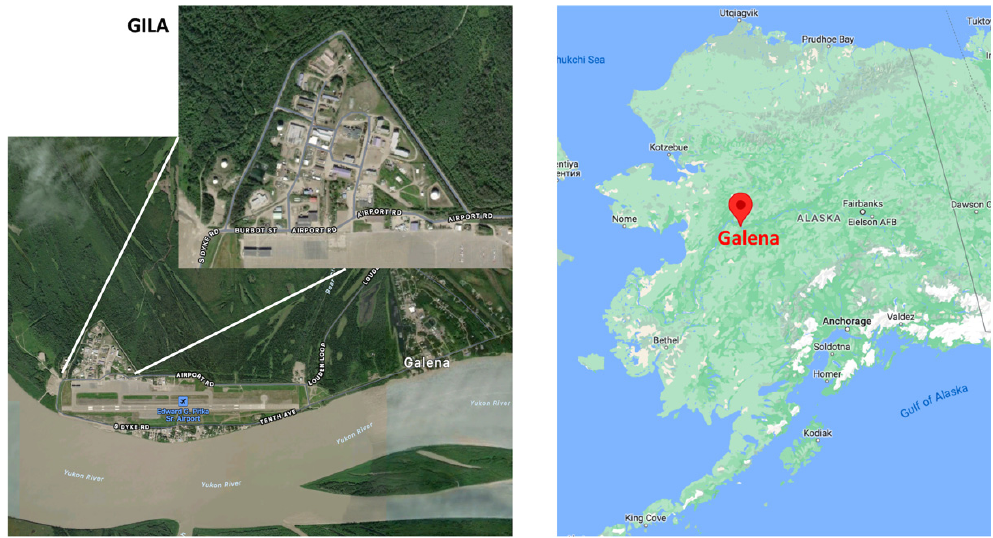
Figure 1. The location of the case-study site. Galena is a town in the Interior Alaska region, and the Galena Interior Learning Academy (GILA) is located at the eastern end of the town. (Source: Apple maps, accessed on 21 June 2022).